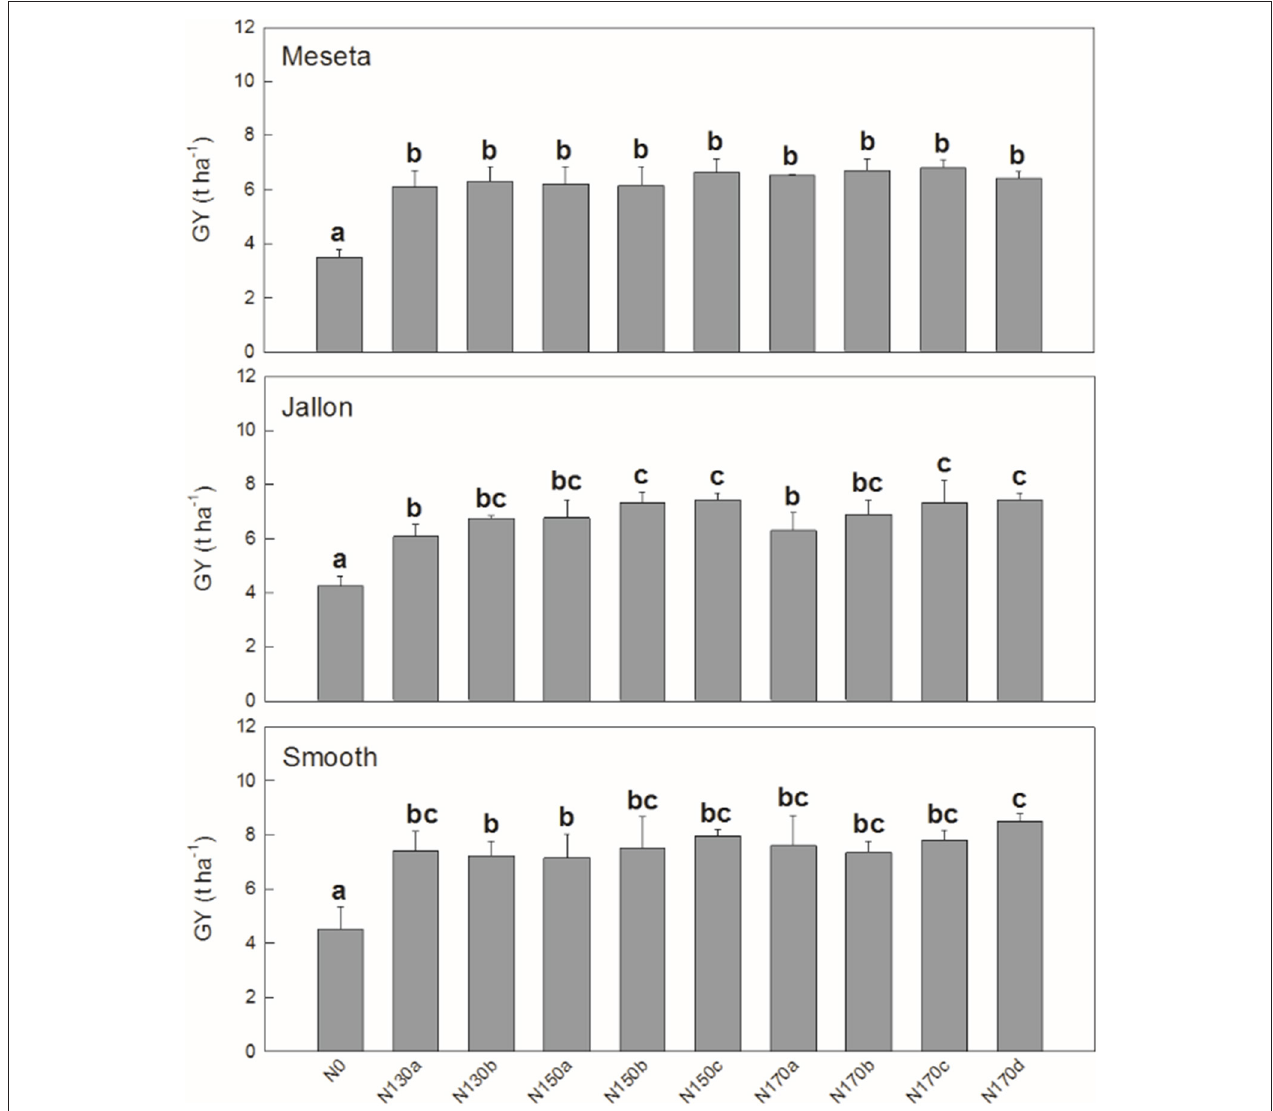
FIGURE 4 | Meseta (conventional), Jallon (hybrid), and Smooth (hybrid) barley varieties. Each value is the mean ± SD for each genotype separately for each nitrogen supply ( n = 3 for genotype replicates and n = 9 for N supplies). Bars with different letters are significantly different at P <